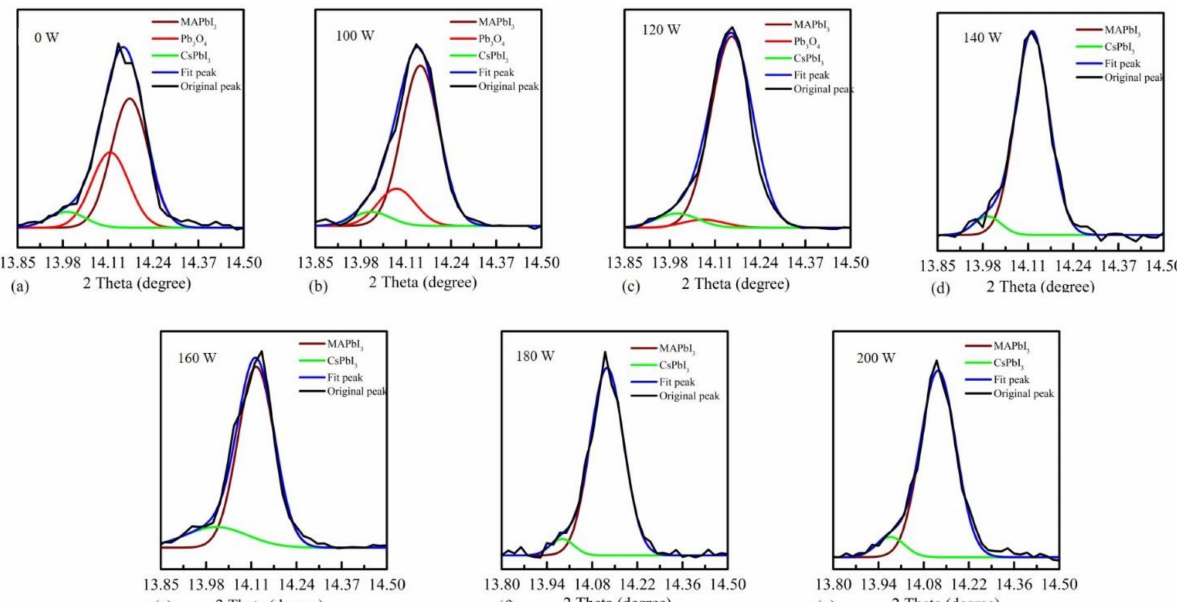
Figure 6. ( a – g ) XRD fitting patterns of composite perovskite treated by argon plasma at different